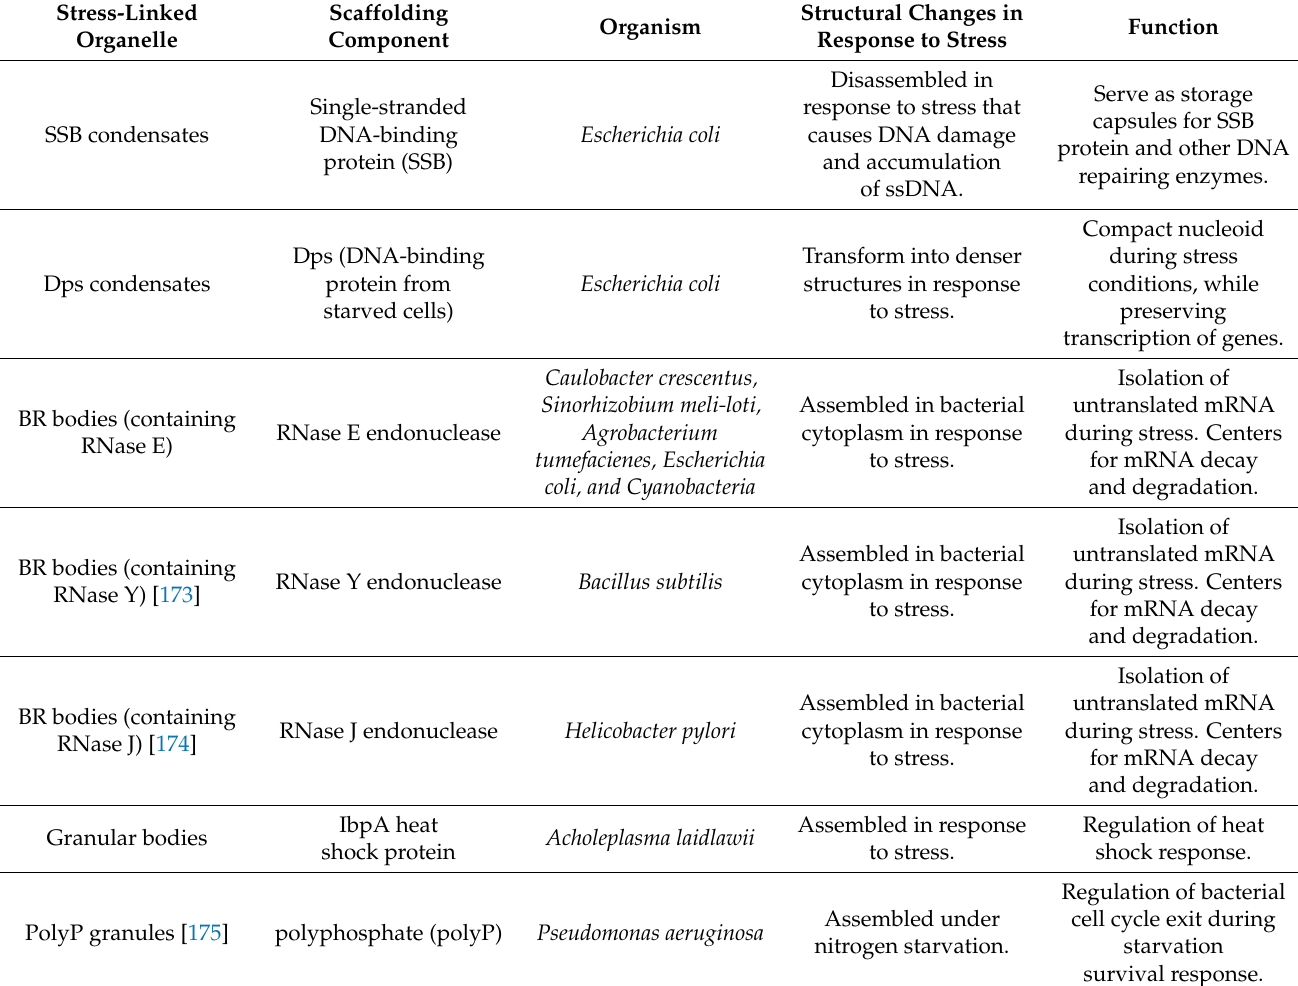
Table 3. Examples of LLPS (or suggested to be LLPS) compartments formed or rearranged in response to in prokaryotic